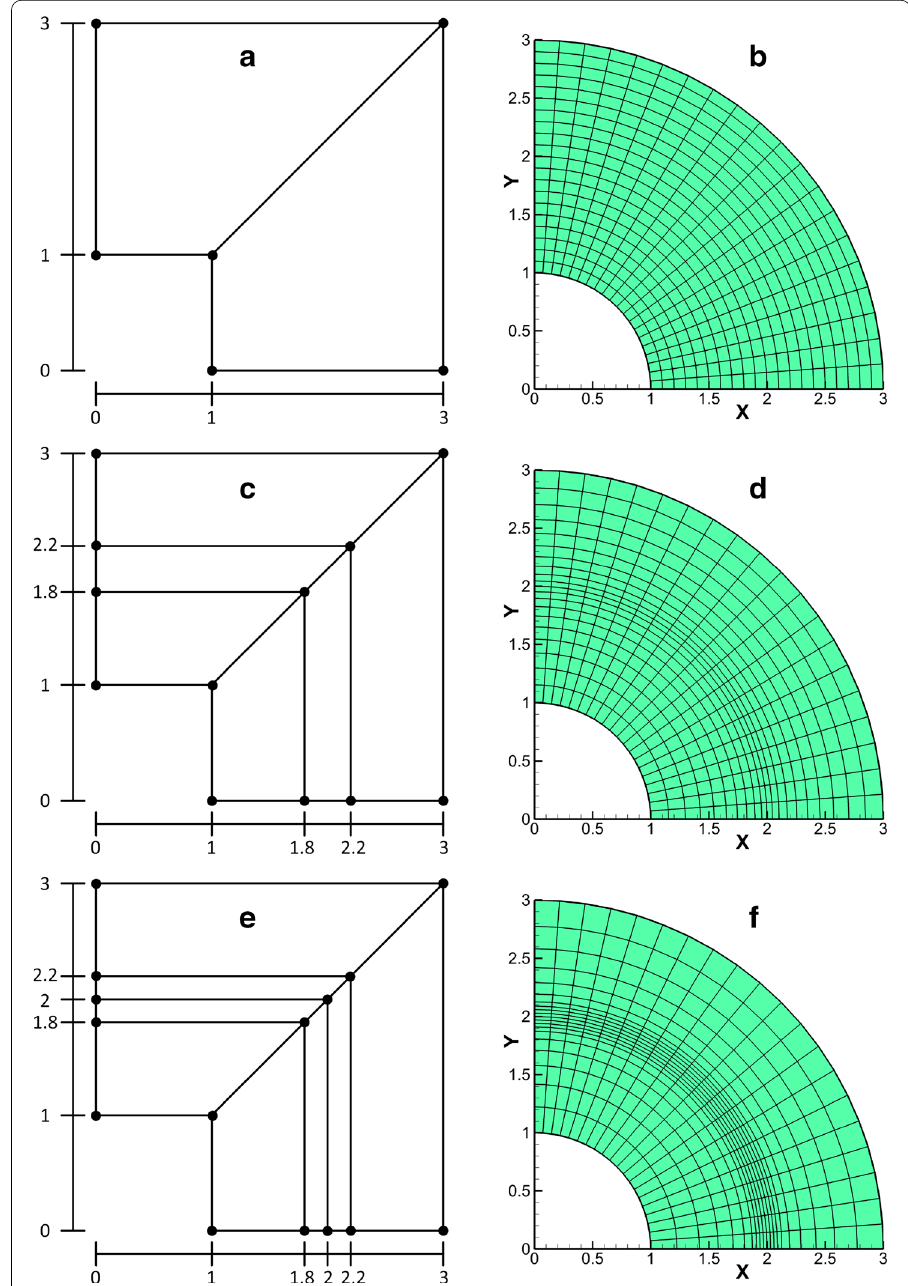
Fig. 18 Different control nets to represent the same geometry but with different stretching to capture accurately steep gradients ( a , c , e ) and ( b , d , f ) corresponding NURBS